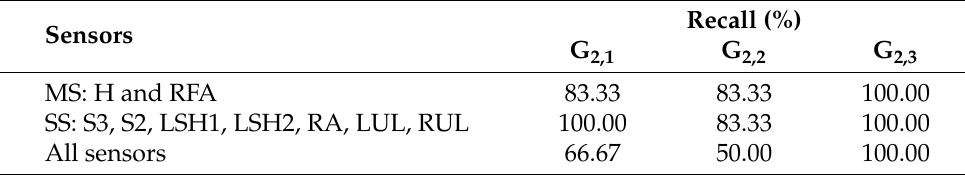
Table 8. Recall achieved for G 2 using HMMs.